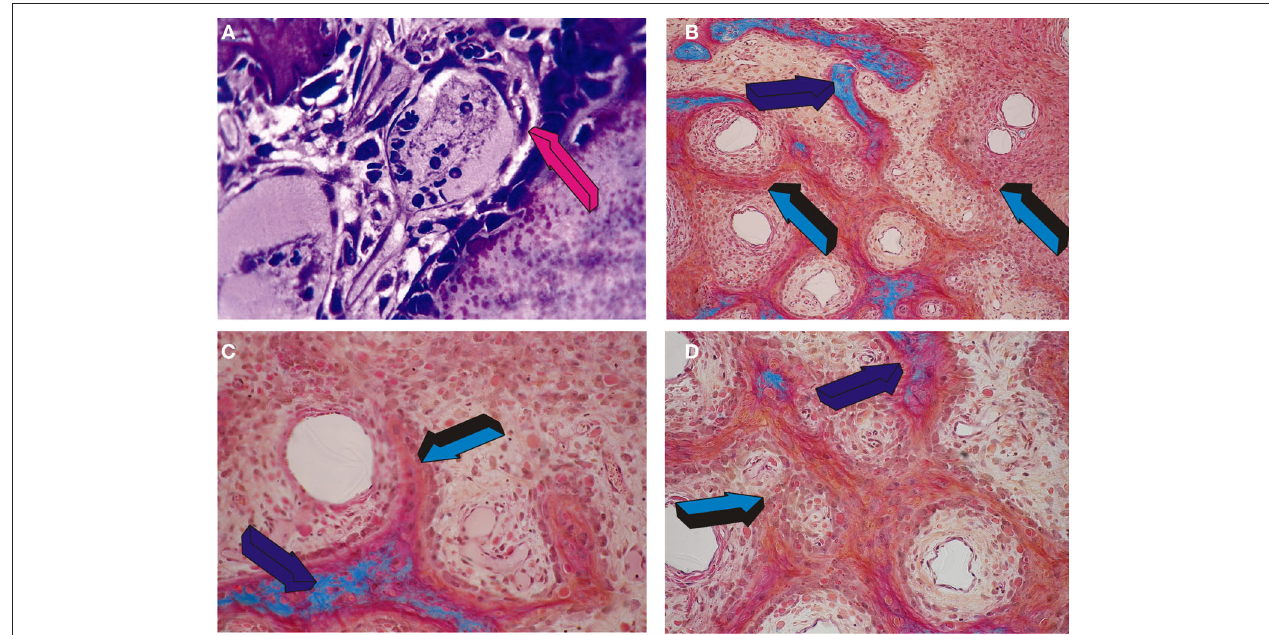
Figure 1 | Angiogenesis, capillary sprouting, vascular invasion, cellular trafficking, cell differentiation and the induction of the primate cortico- cancellous osteonic bone. (A) Endothelial-like cell detachment and migration from the vascular compartment (magenta arrow) to the bone-forming osteogenetic compartment (top right of magenta arrow); (B–D) osteogenesis in angiogenesis in the non-human primate Papio ursinus . Capillary sprouting and invasion patterning the induction of mesenchymal cellular condensations around the “osteogenetic